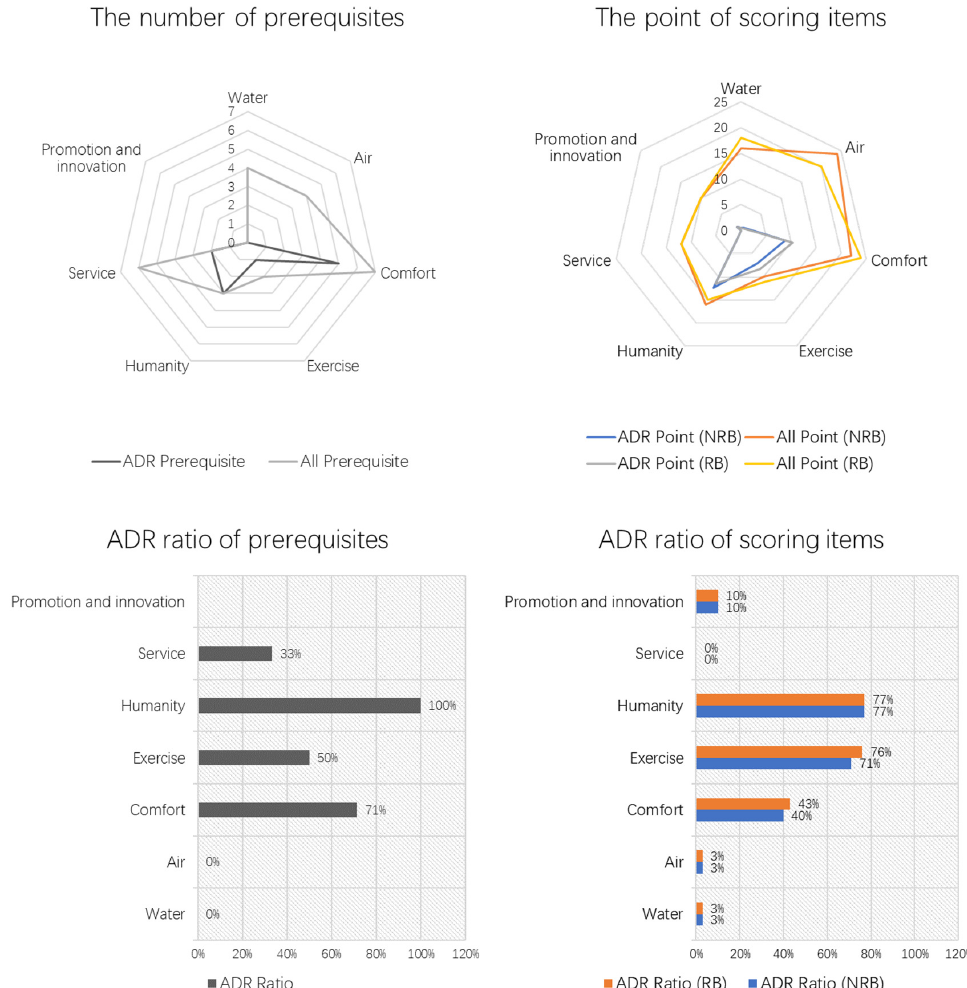
Figure A5. Breakdown of the number of prerequisites, the point of scoring items, and ADR ratios in